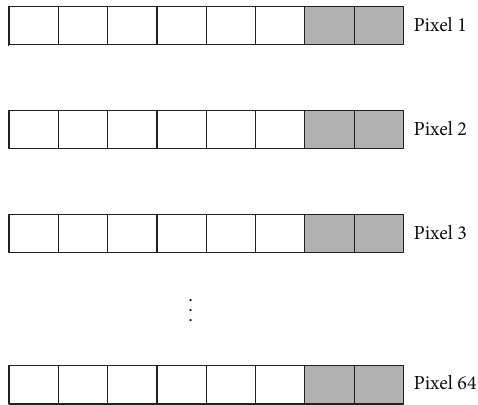
Figure 2: Embedding the recovery data of a ROI block into 2 LSBs of pixels in mapped RONI